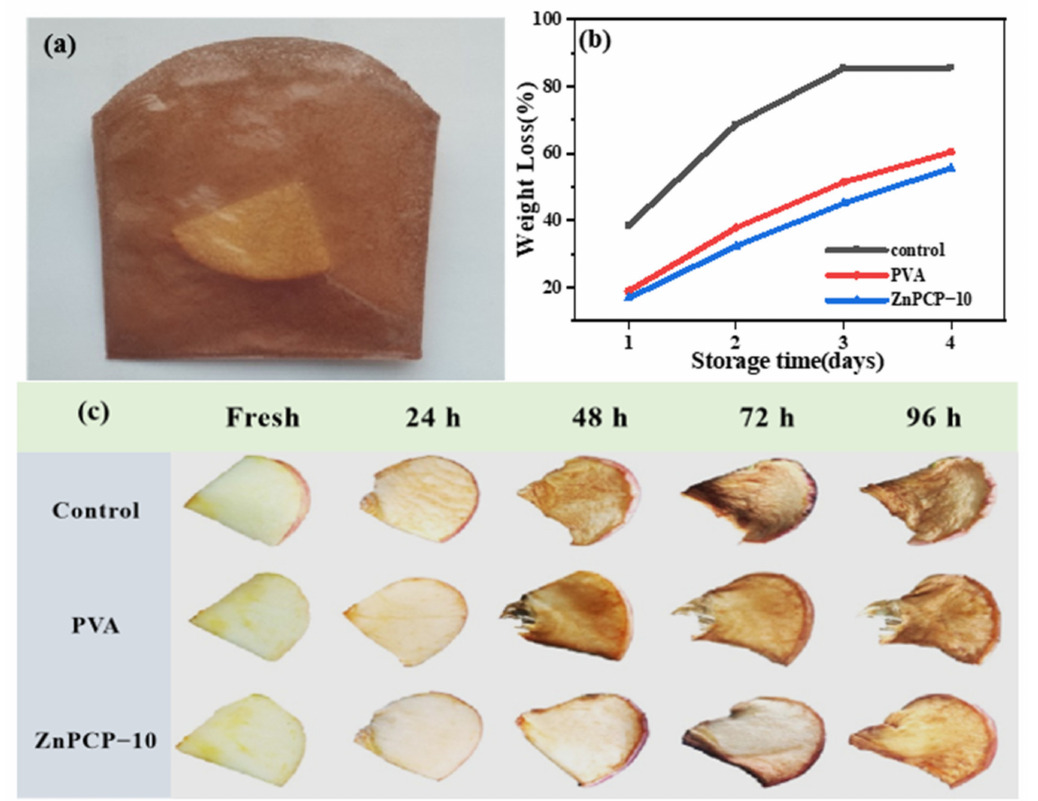
Figure 6. ( a ) ZnPCP − 10 bag with apple slice; ( b ) weight loss and ( c ) fresh-keeping performance for bagged apple